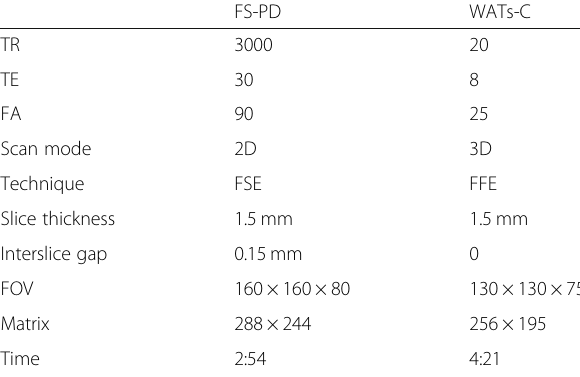
Table 1 MRI pulse sequences used in this